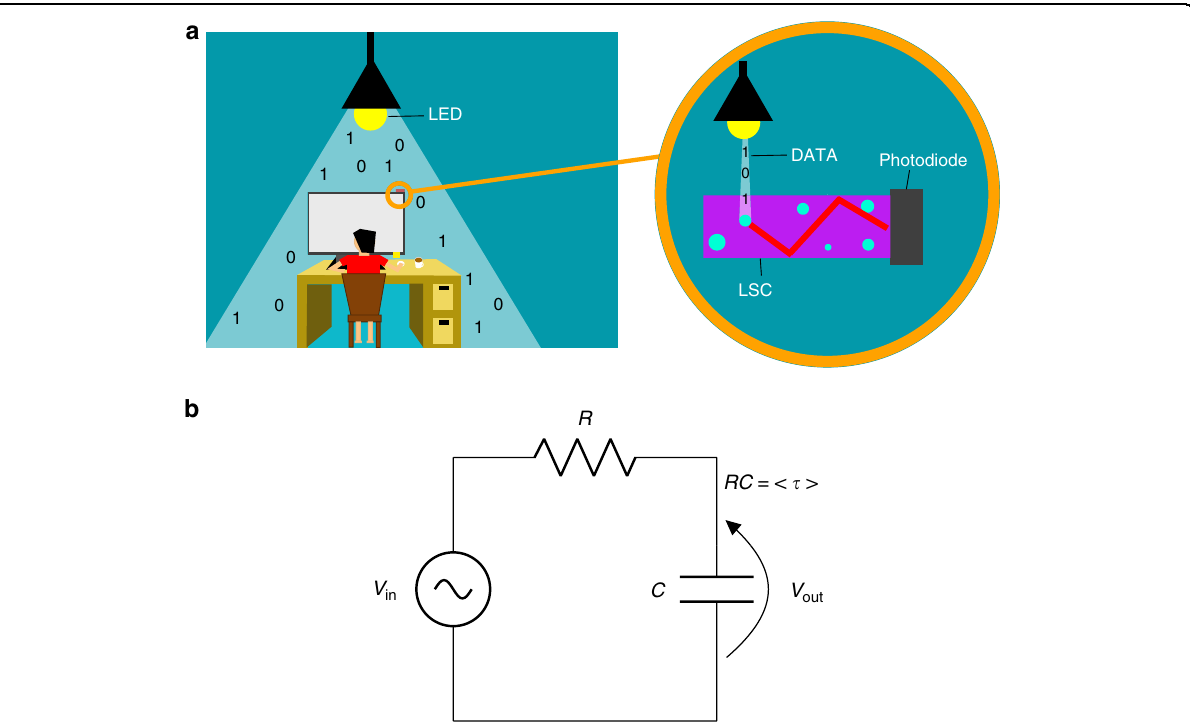
Fig. 1 Overview of luminescent solar concentrators for optical communications. a Graphic depicting the principle of operation of an LSC-VLC system. Data are transmitted by modulating a source of light, typically LEDs. Light may come from any direction and is collected by fl uorescent collectors that concentrate it to a photodiode on their edge. The photodiode converts the optical signal into an electrical signal, which is then processed by the receiver circuits. b At their limits, LSCs can be represented by a simple RC circuit, where V in is the input and represents the absorbed incident